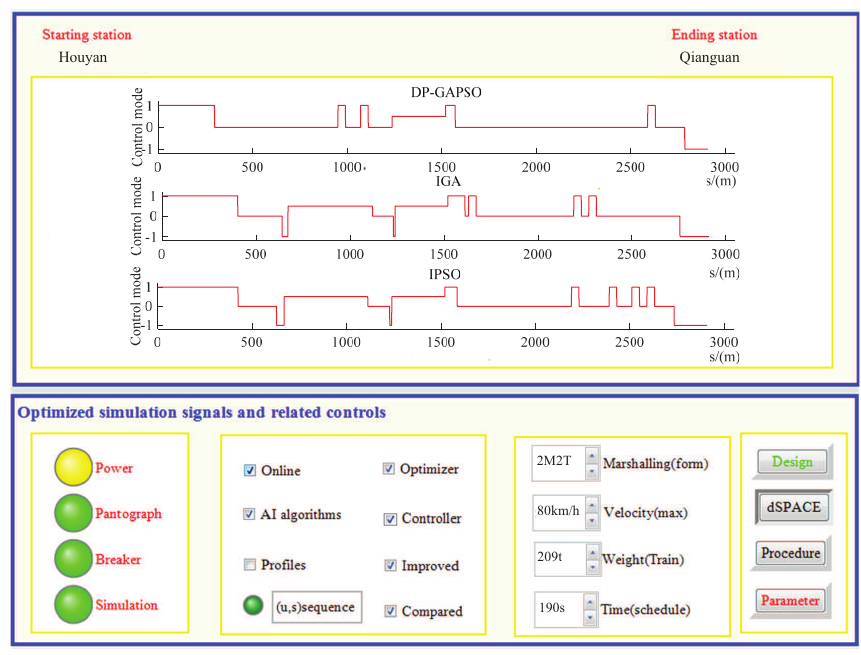
Figure 19. The operating condition distance curve of the train from Houyan to Qianguan. Table 13. The simulation results obtained by three different algorithms from Houyan to Qianguan.